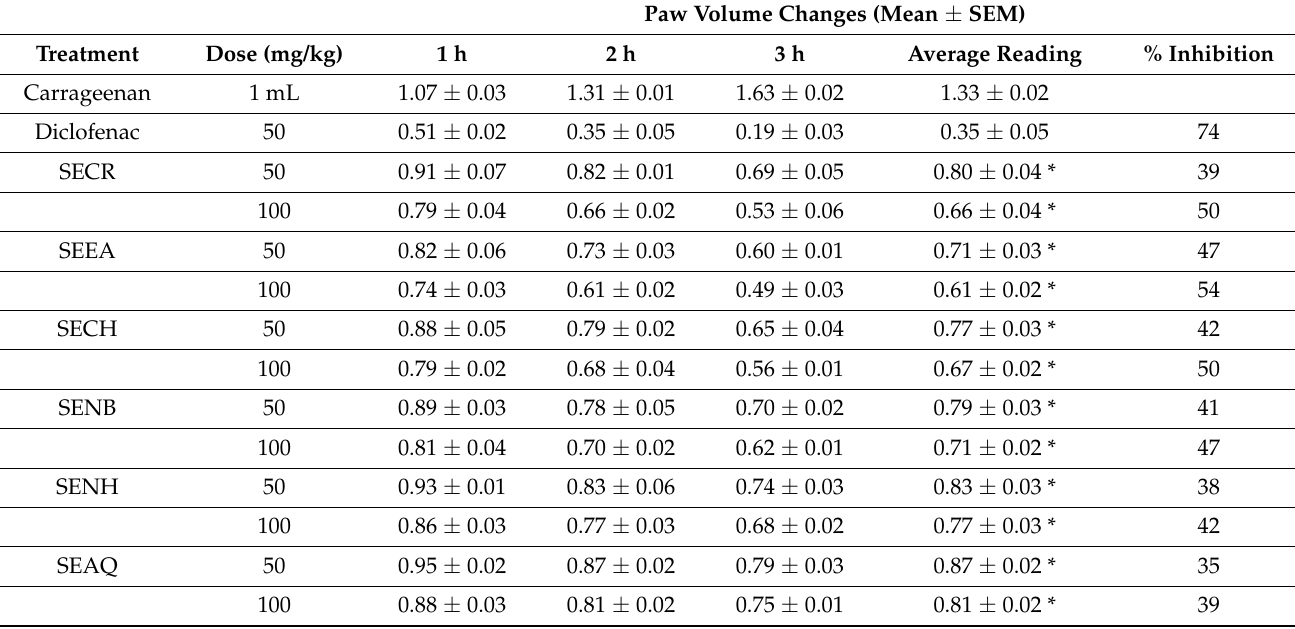
Table 4. Anti-inflammatory potentials of S. edelbergii extracts. Paw Volume Changes (Mean ±